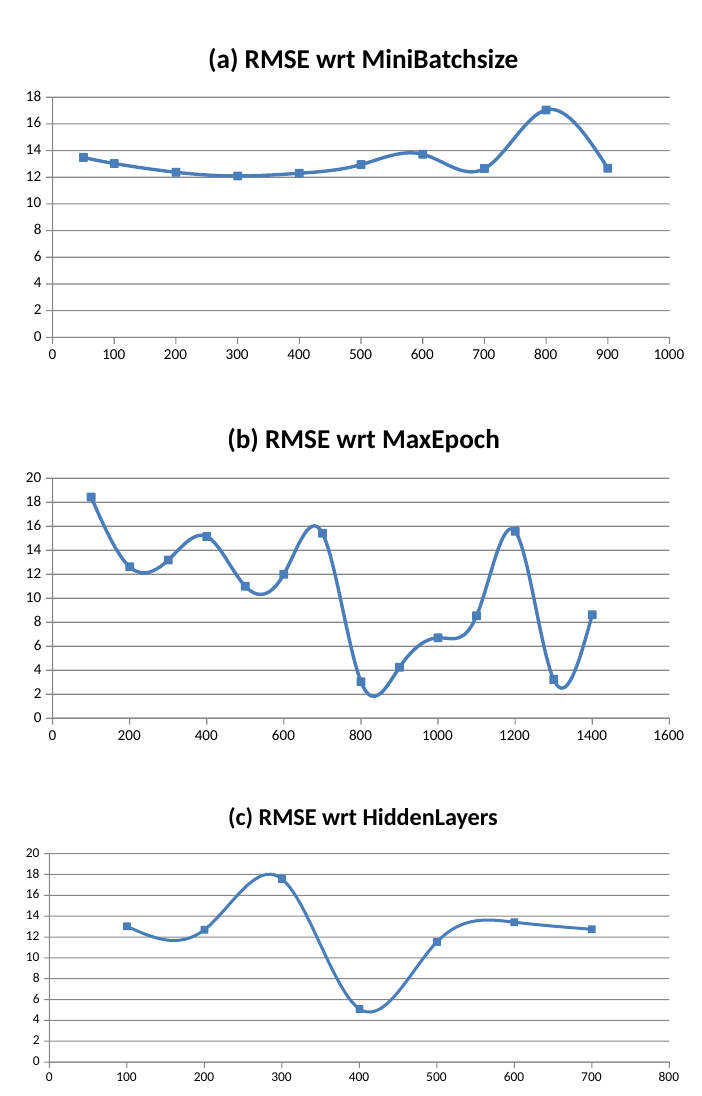
Figure 2. Graphics showing the evolution of the chosen RNN parameter when the other two have a value of 200, ( a ) shows the influence of the MiniBatchSize, ( b ) the influence of the MaxEpoch and ( c ) the influence of hidden